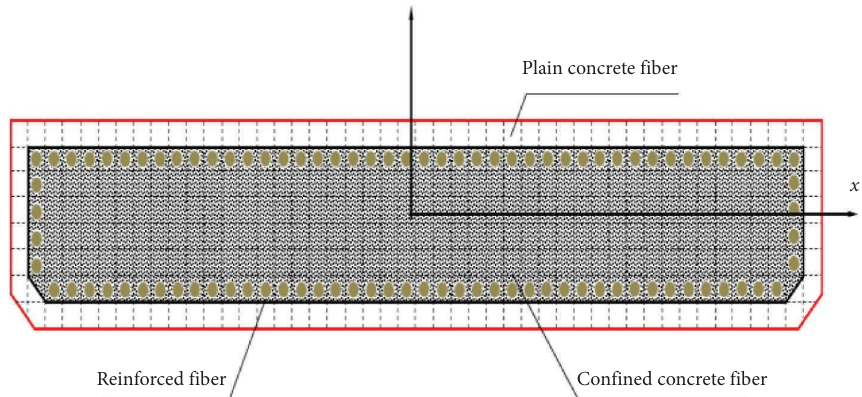
Figure 8: Capping beam fber beam element model.